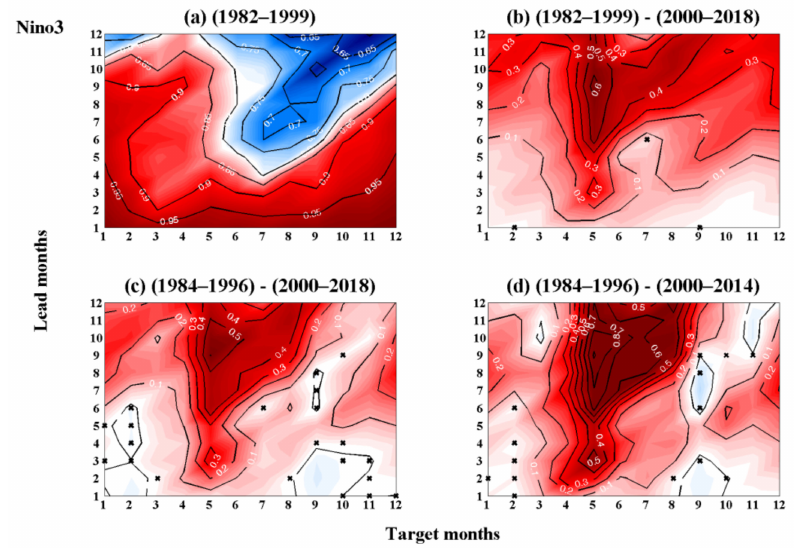
Figure 3. As in Figure 2, but for the Niño3